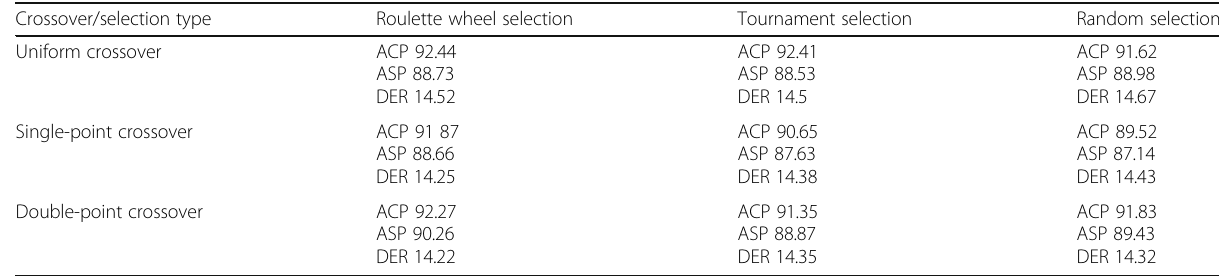
Table 6 DER results obtained for GA algorithm with WCD index, using different selection as well as different crossover modes Crossover/selection